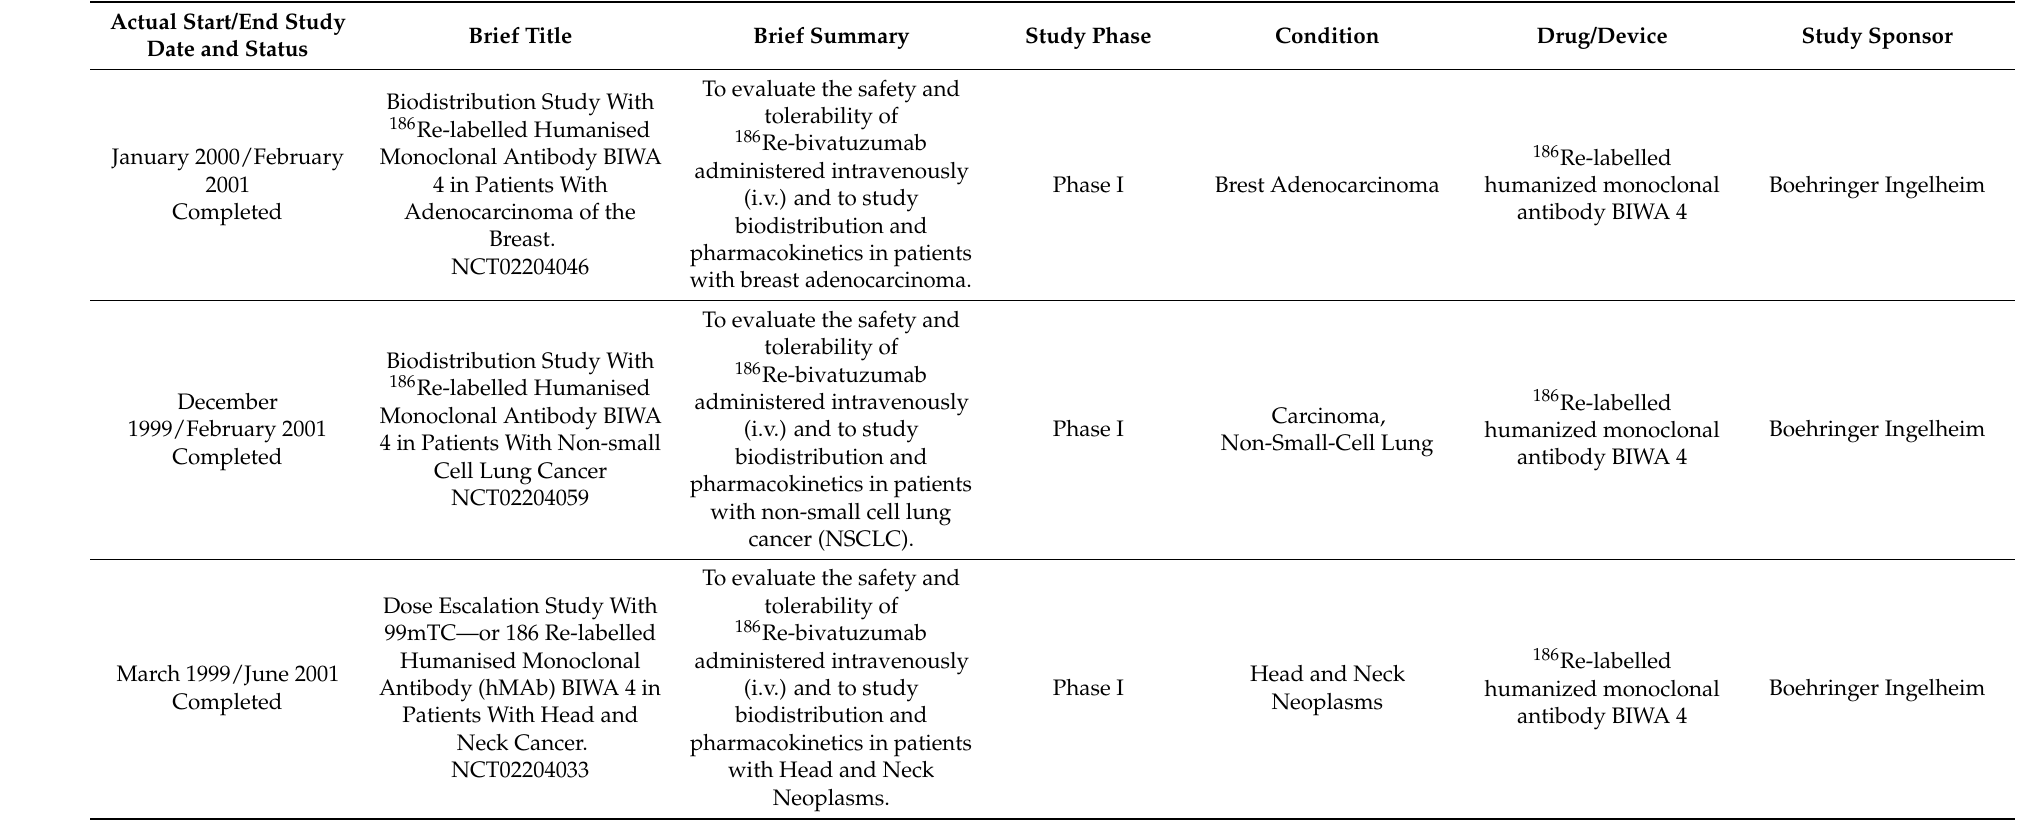
Table 4. Clinical trials involving 188/186 Re compounds. NA = not applicable